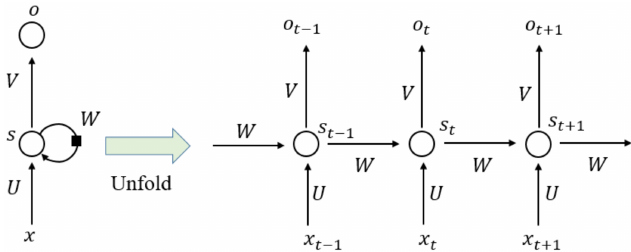
Figure 9. Schematic structure of recurrent neural